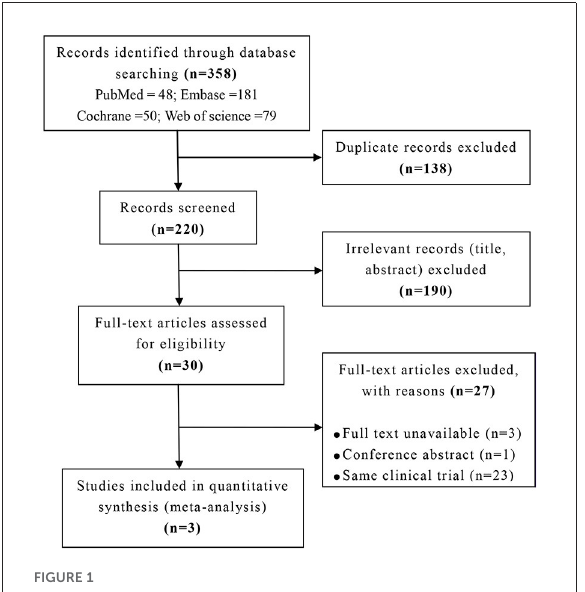
FIGURE1 Flow chart of literature